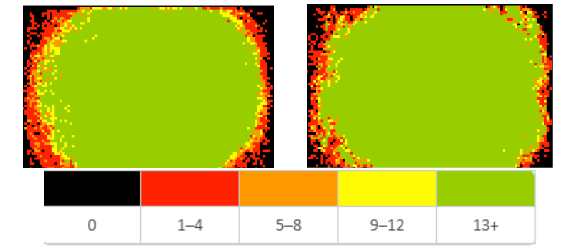
Figure 3. Relative only Point Density (#points/location) visualization with vignetting correction (left) and without vignetting correction (right) Vignetting Correction Table 4. Interior Orientation Results